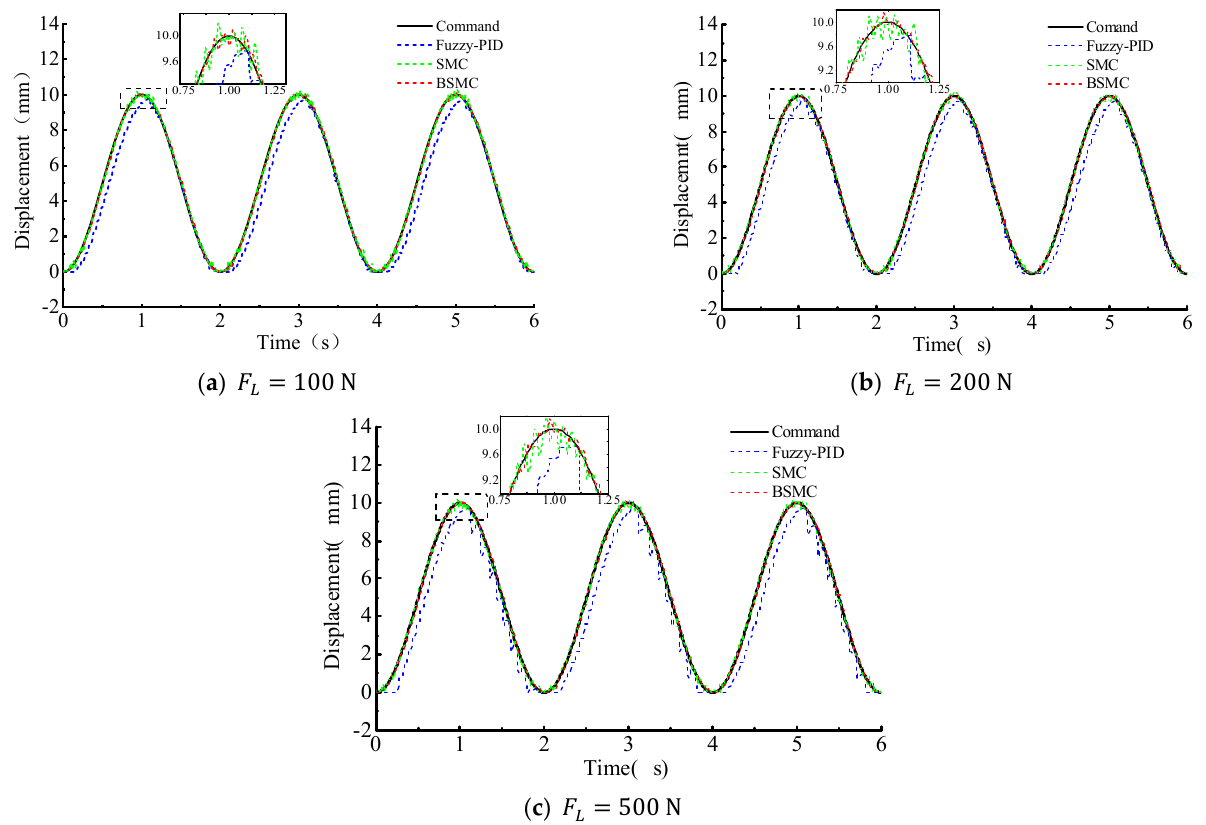
Figure 5. Sinusoidal response of the cylinder: ( a ) 𝐹 𝐿 = 100 N ; ( b ) 𝐹 𝐿 = 200 N ; ( c ) 𝐹 𝐿 = 500 N .